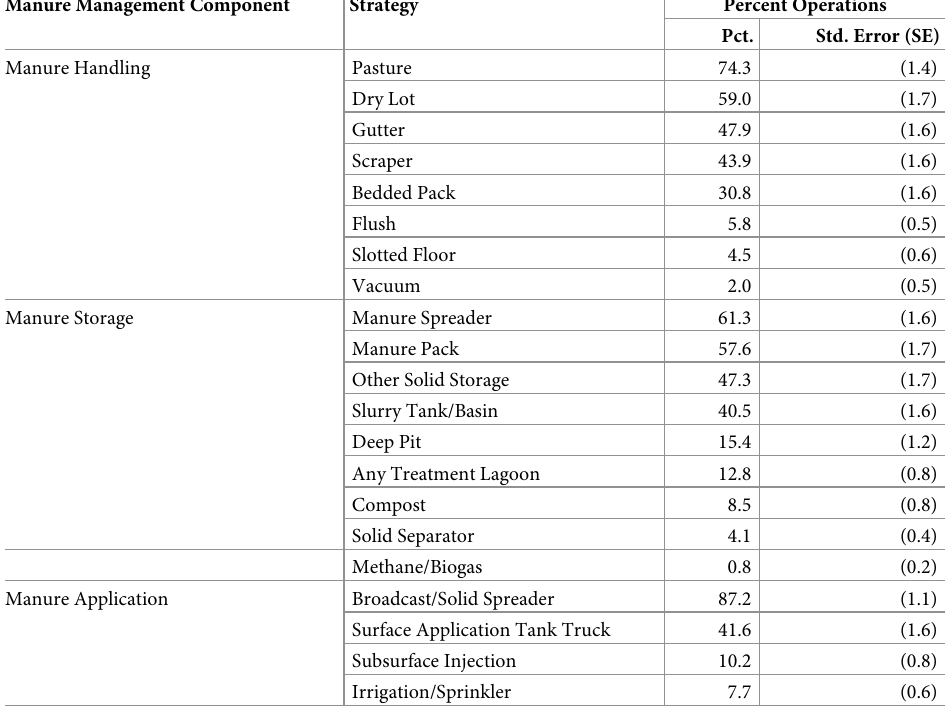
Table 2. Percentage of operations by manure handling strategy in cow housing areas, manure storage strategy, and, for the 98.3 percent of operations that applied manure to land owned or rented by the operation, percentage of operations by manure application